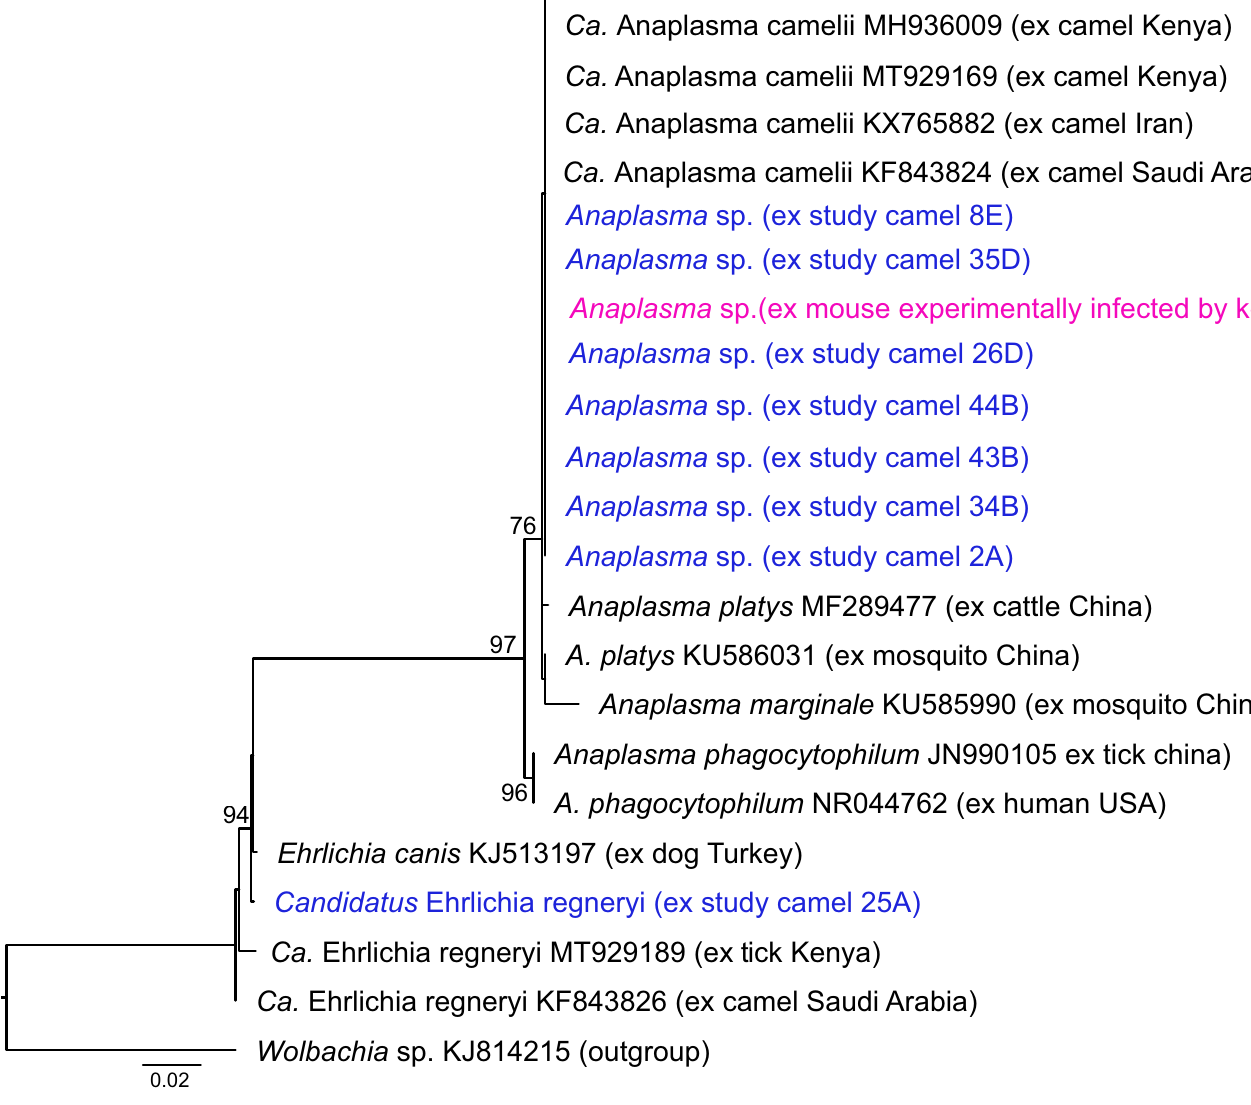
Fig 6. Maximum-likelihood phylogenetic tree of 1000-bp Anaplasma sp. 16S rRNA sequences. The sequences obtained from this study are shown in pink and blue colours and bootstrap values at the major nodes are the percentage agreement with 1000 bootstrap replicates. Wolbachia endosymbiont KJ814215 (family Anaplasmataceae ) was included in the tree as